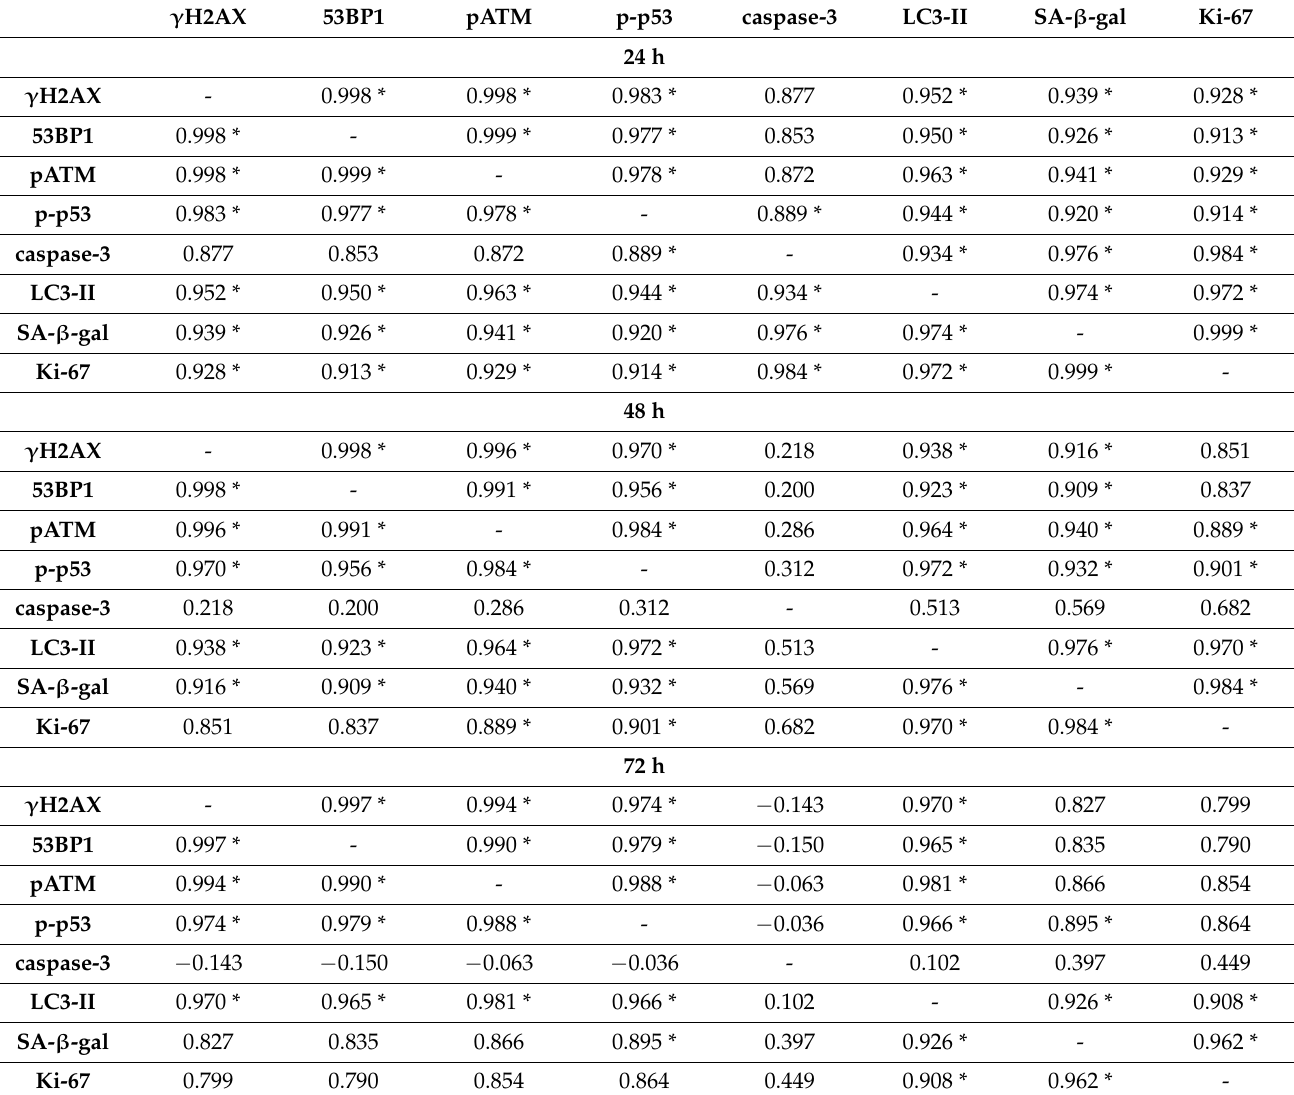
Table A3. Correlation matrices for the investigated endpoints at 24, 48 and 72 h after X-ray